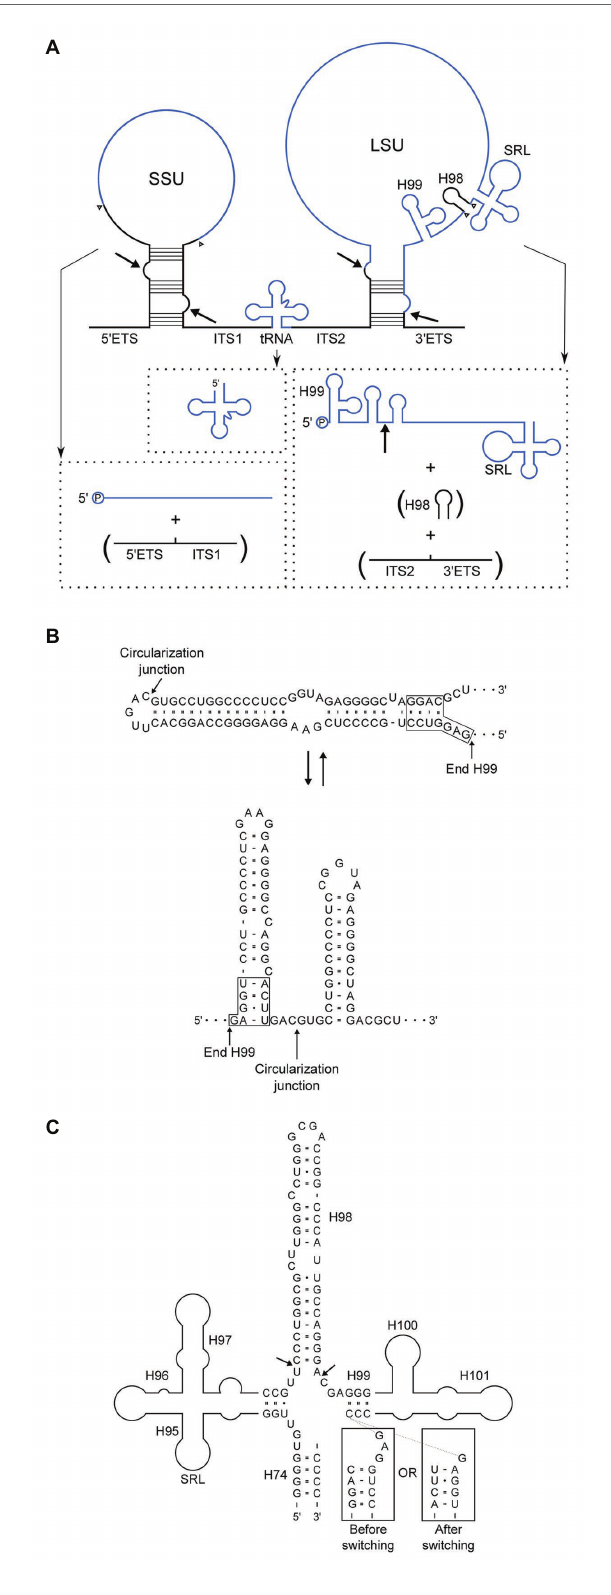
FIGURE 6 | (A) Model of pre-rRNA processing in Pyrococcus furiosus including the rRNA precursor and final products. By-products that are turned- over are in parentheses. Intermediates, e.g., putative circular forms, were not included because the order of processing steps was not determined with certainty. Arrows indicate the proposed processing sites at BHB motifs and the circularization junction in the mature LSU rRNA, and arrowheads show the final processing sites for generation of the mature products. End-products are in blue and spacers in black. (B) Two alternatives base pairing schemes after circularization. The upper correspond to H1 in conventional annotation extended by 15 bp and closed by a loop. In the lower structure this helix is resolved into two helices spanning the circularization junction. (C) Structural context of H98 removal. H98 is located between H95 and H97 comprising the Sarcin-Ricin Loop (SRL) and H99–H101 involved in binding of the signal recognition particle (SRP). The arrows indicate the processing sites mapped by RiboMeth-seq analysis. The boxed sequences are similar to those in (B) and are appended to the 3 ´ -strand of H99 to show how the alternative base pairing affects the structure of the junction at which H98 excision takes